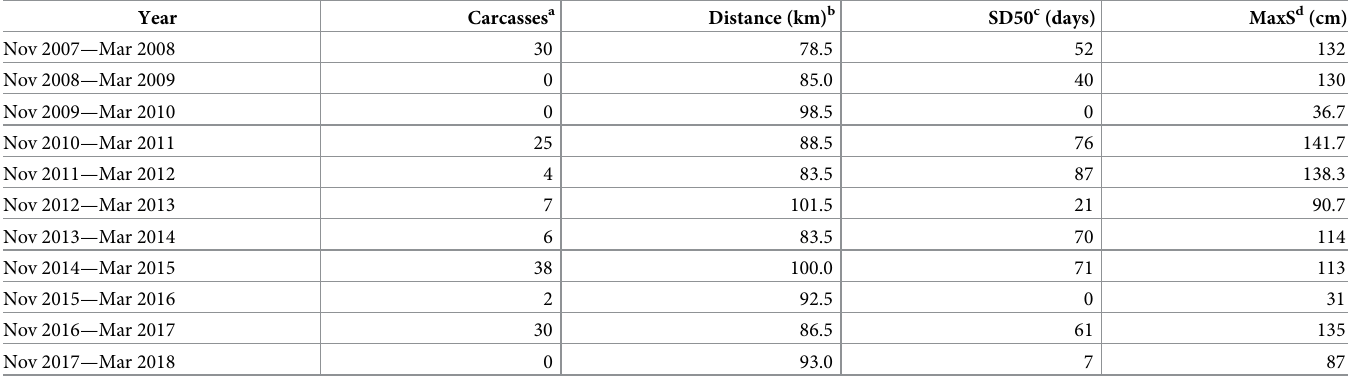
a Number of deer carcasses b Distance of the total survey area during spring thaw c Snow cover > 50 cm duration d Maximum snow depth at 356 m elevation at the Ashiu Forest Station.